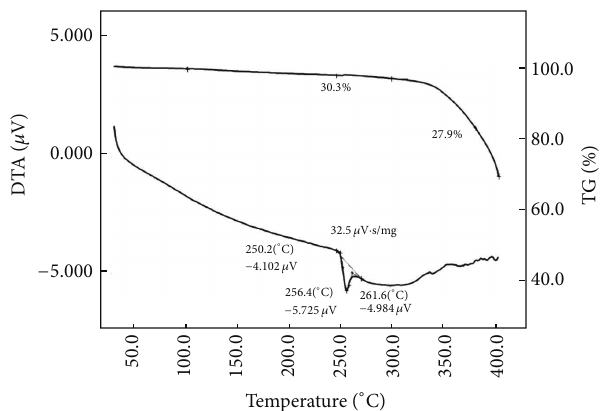
Figure1:Thermogravimetricanalyzer(TGA)analysisofmembrane of PVA-PES.